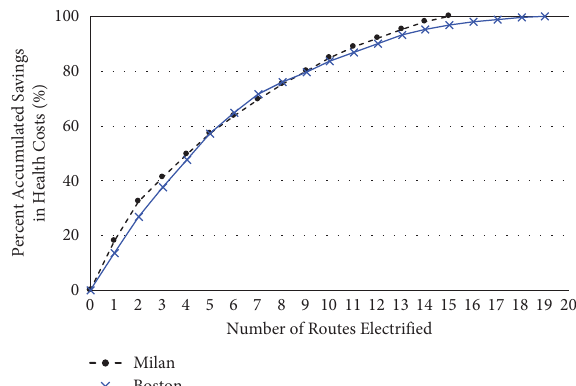
Figure 12: Percent savings of health costs by bus